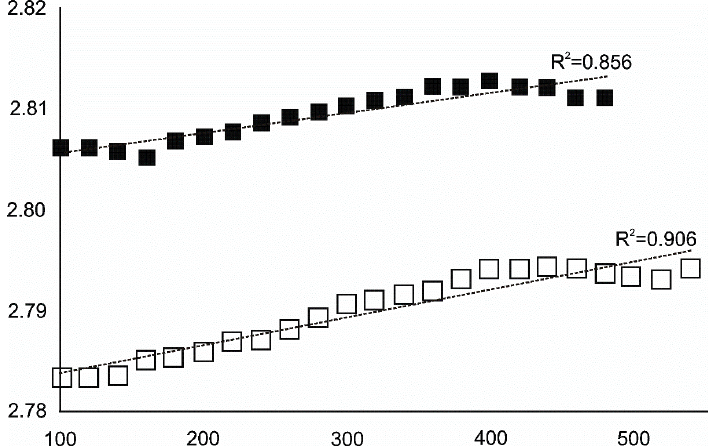
Figure 8. Relation of the main reflection (hkl = 104) position (in Å) of siderite to temperature (bottom axis, °C). Symbols as in Figure 7.